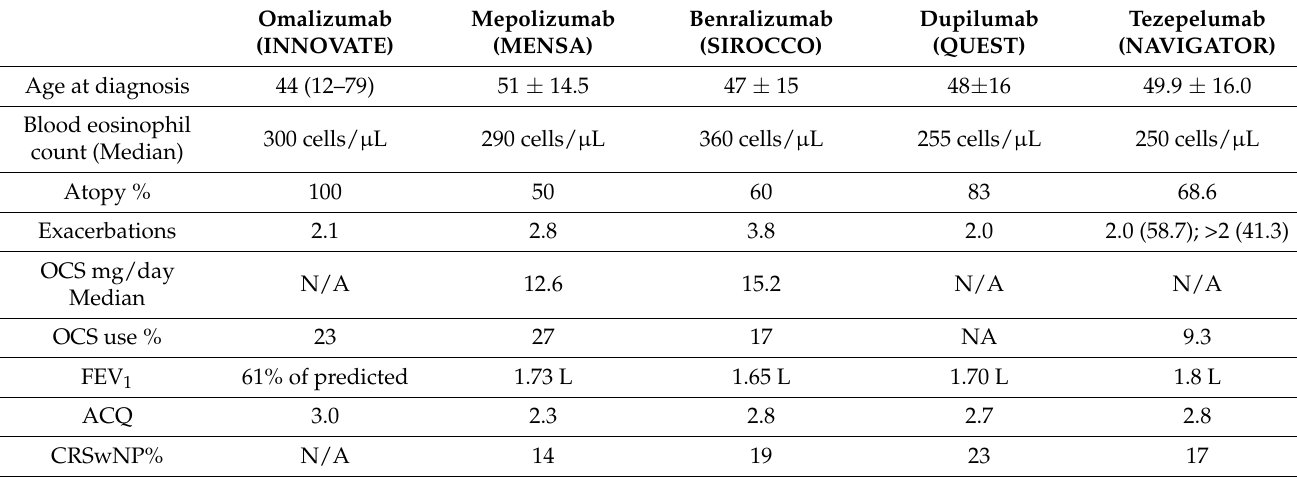
Table 4. Comparison of baseline